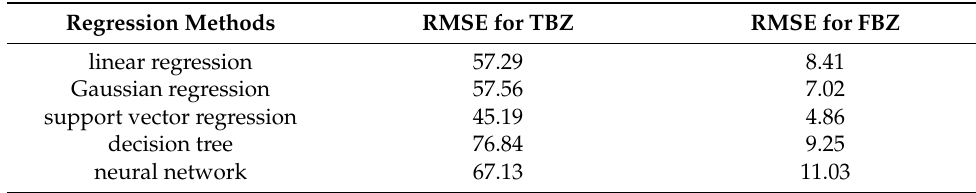
Table 2. Performance of Different Algorithms for Extraction Method. Regression